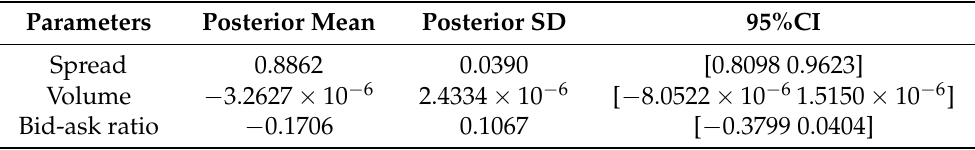
− 153,001 Smoothing Parameters